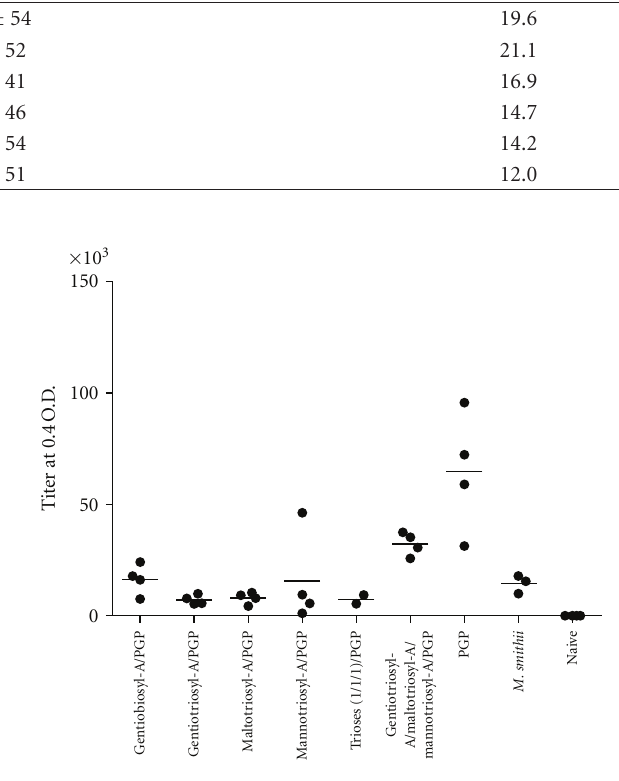
Figure 4: Antibody titres in sera of mice immunized with various archaeosome adjuvants. Peripheral blood was collected at 5.5 weeks, just prior to euthanizing mice for spleen removal (Figure 1). Each data point shown represents the titre in the serum from an individual mouse. Means were significantly higher for the OVA- PGP archaeosome vaccinated group ( P < 0 . 05) compared to all groups except for Gentiotriosyl-A/Maltotriosyl-A/Mannotriosyl- A/PGP ( P = 0 .